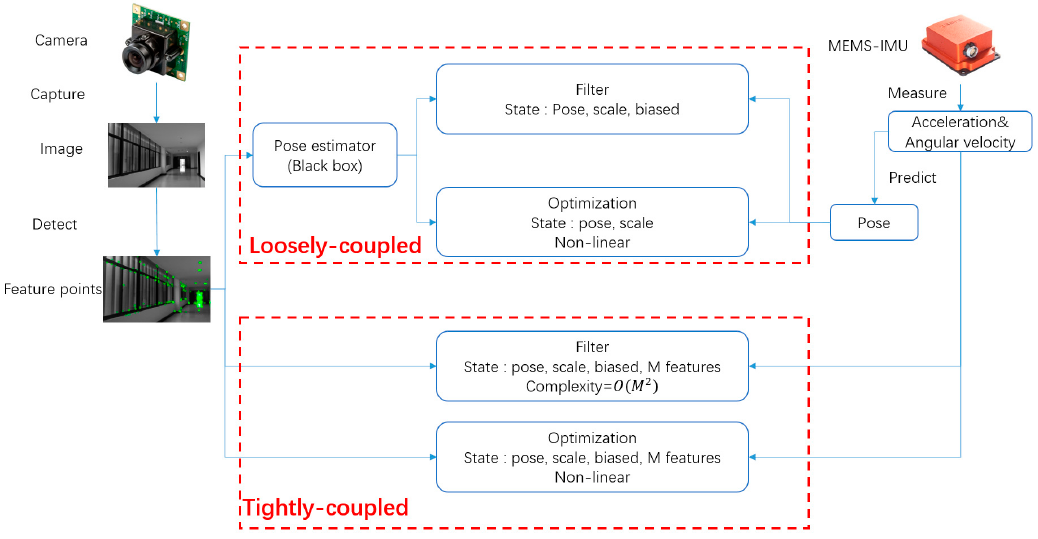
Figure 1. Loosely and tightly coupled visual inertial odometry (VIO).